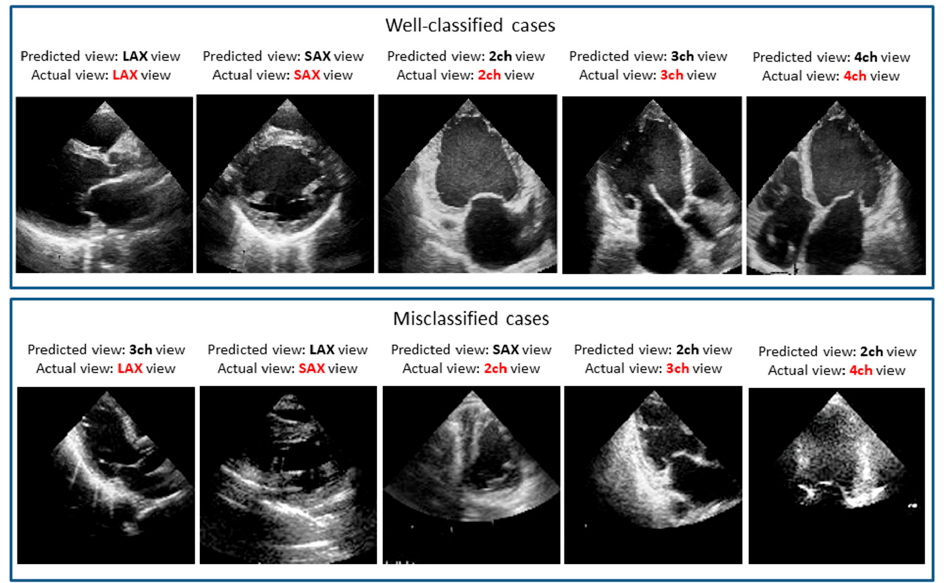
Figure 4. Well-classified and misclassified cases: For the misclassified cases, it seems to be difficult even for expert observers to determine the accurate view.